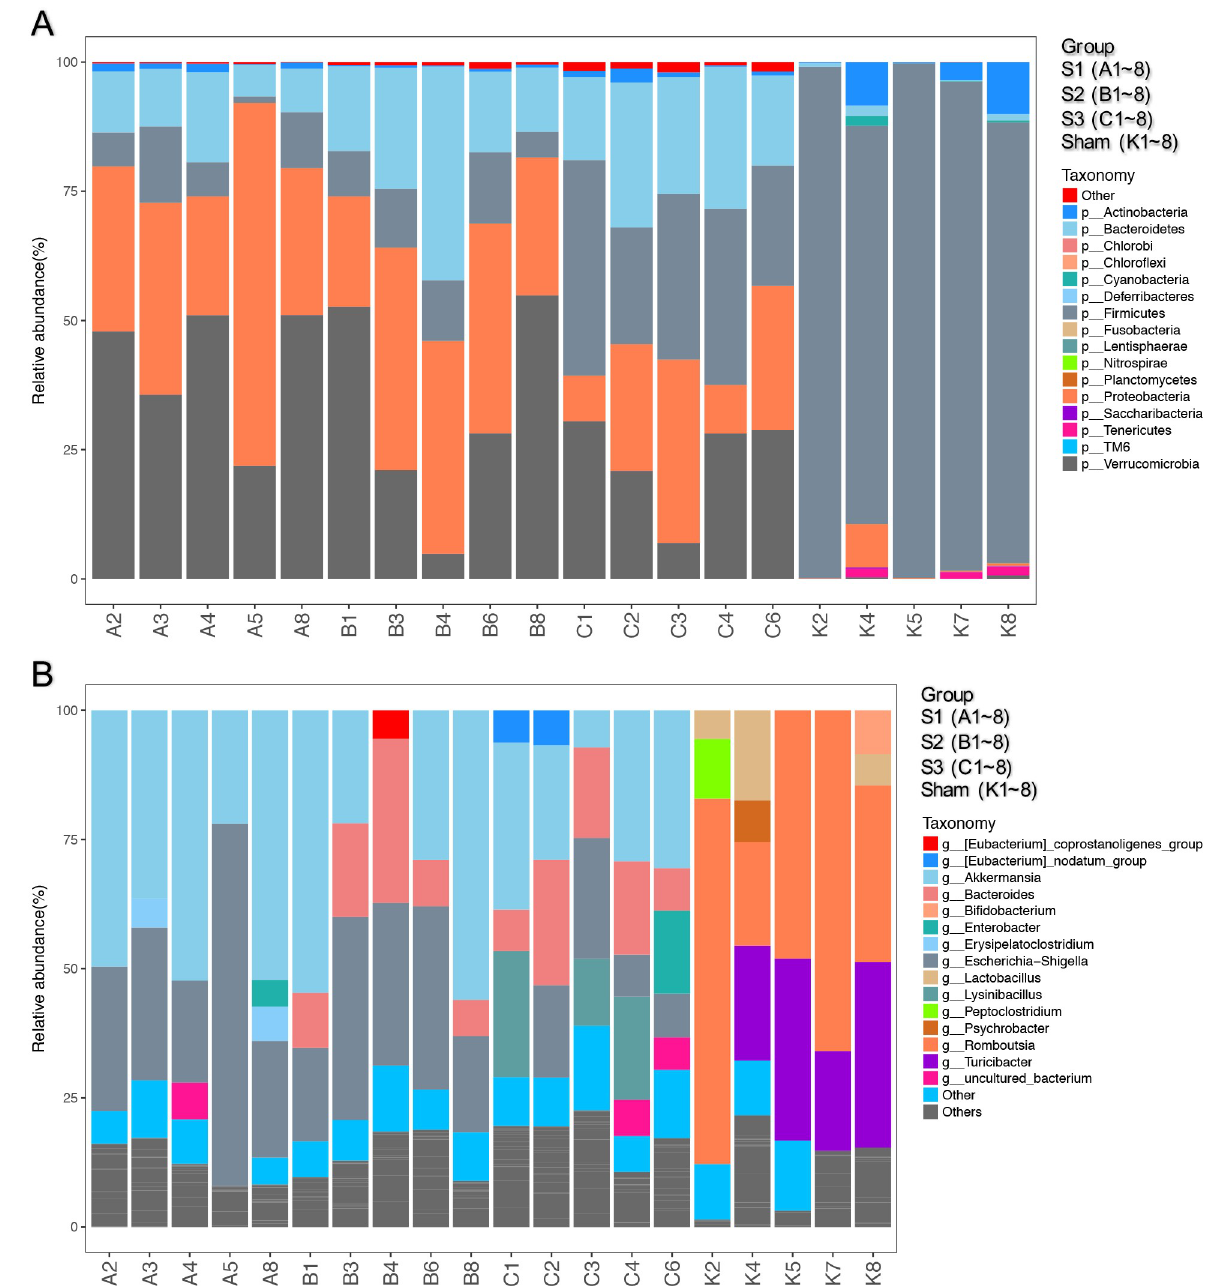
Fig 6. Comparison of small intestinal microbiota composition in sham and SBO rats. Intestinal microbiota composition at Phylum level (A), Genus level (B) are shown in the figure.